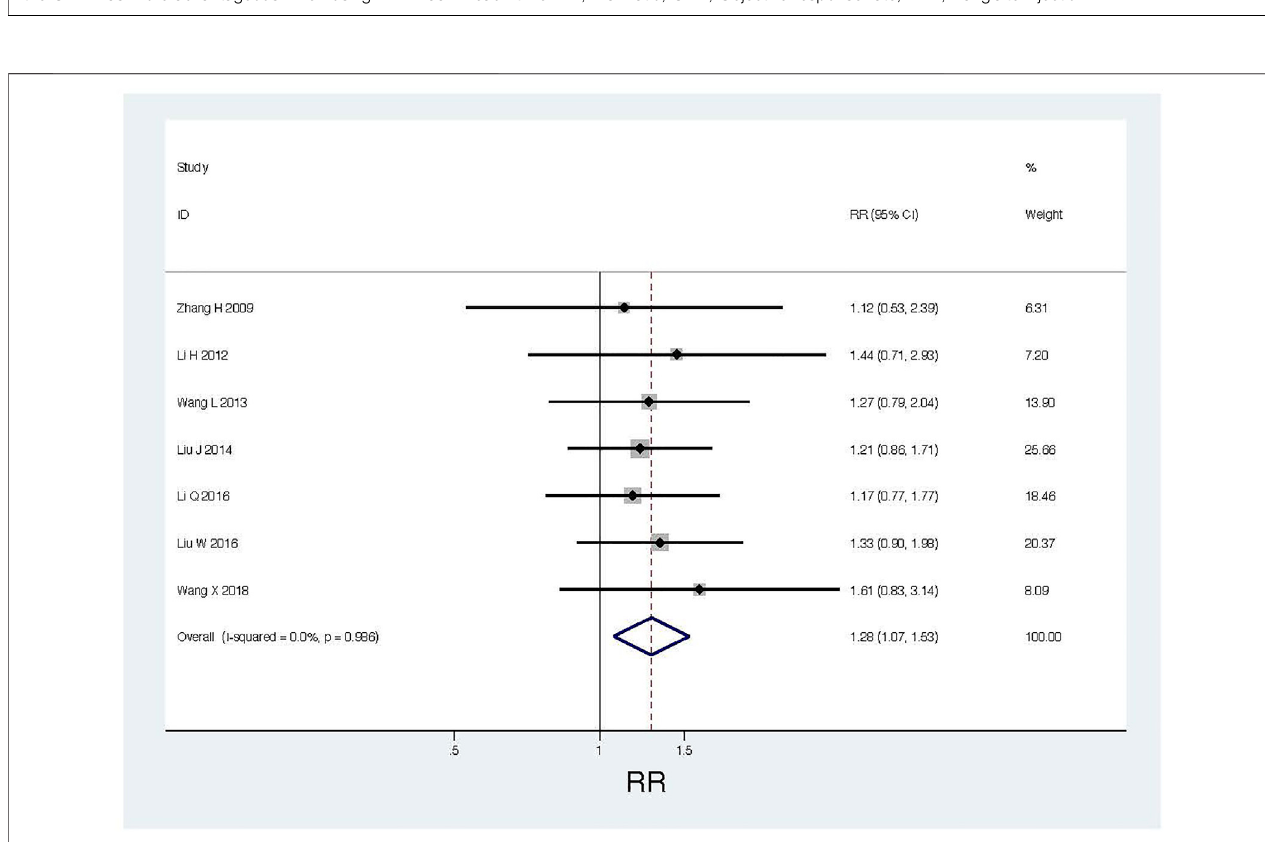
FIGURE 4 | Thoracic perfusion of KLTI combined with other agents improved the QOL of patients with MPE compared with other agents alone. RR, Risk ratio; QOL, Quality of life; KLTI, Kanglaite injection.